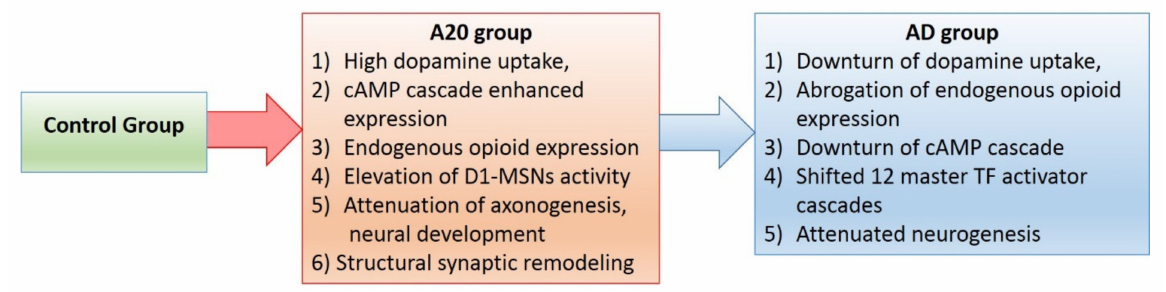
Figure 15. Flowchart of DEG inferred events from aggressive to control